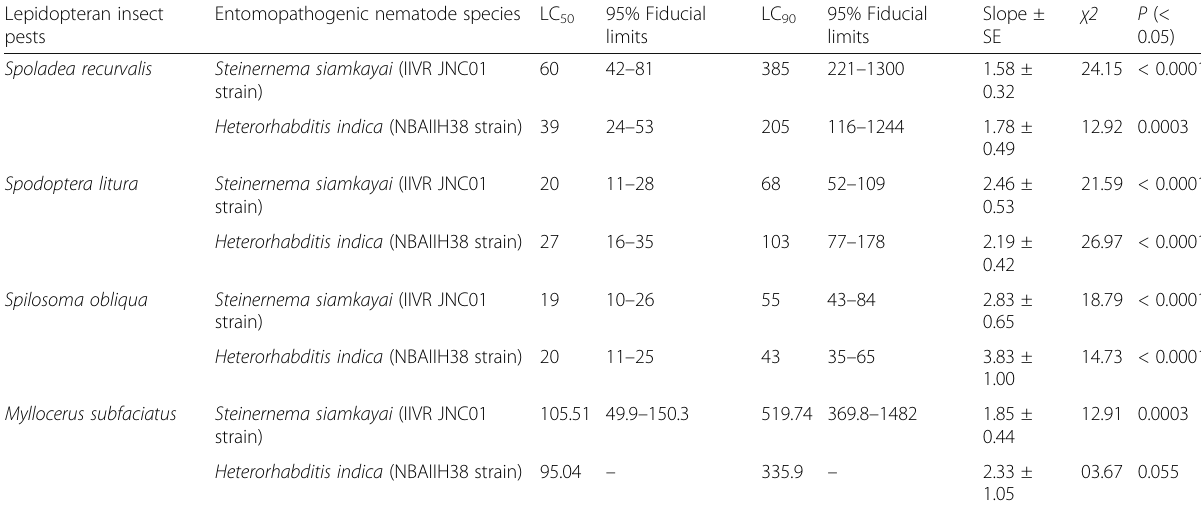
Table 4 The lethal concentration (LC 50 and LC 90 ) of Steinernema siamkayai (IIVR JNC01 strain) and Heterorhabditis indica (NBAIIH38 strain) against lepidopteran pests at 2 days after treatment and eggplant ash weevil ( Myllocerus subfaciatus Guerin.) at 7 days after treatment